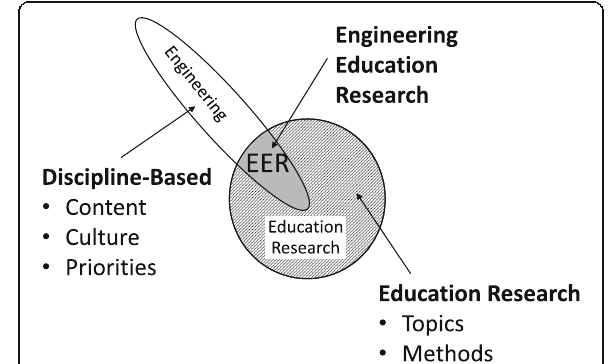
Fig. 1 Each DBER field exists at the intersection of a STEM discipline and the discipline of education research (image based on initial conceptualization by Mark Connolly)